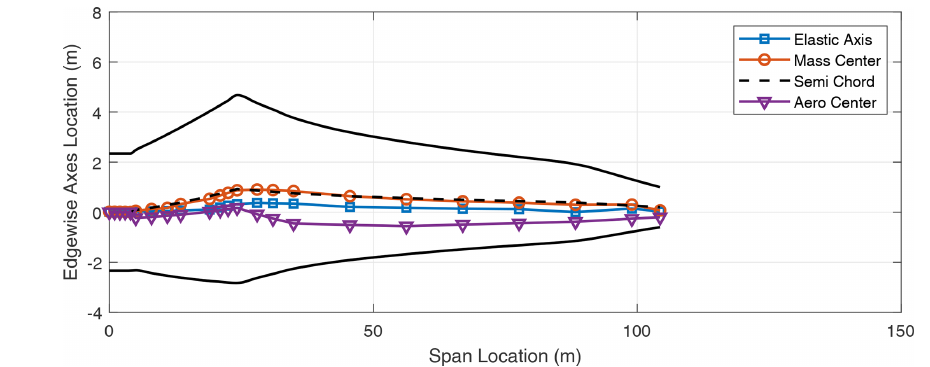
Figure A10. Planform for the SUMR13A turbine blade.